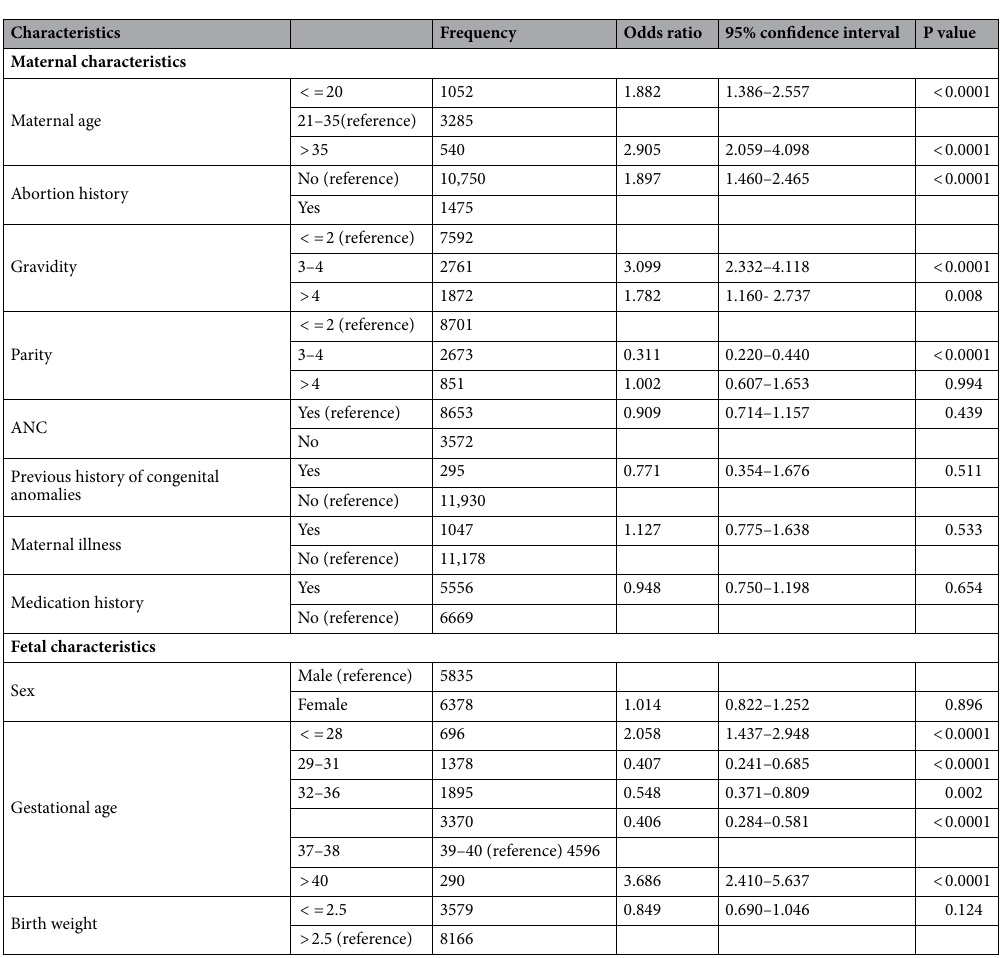
Table 4. Association of major congenital malformation in relation to maternal and fetal characteristics, Tigray,